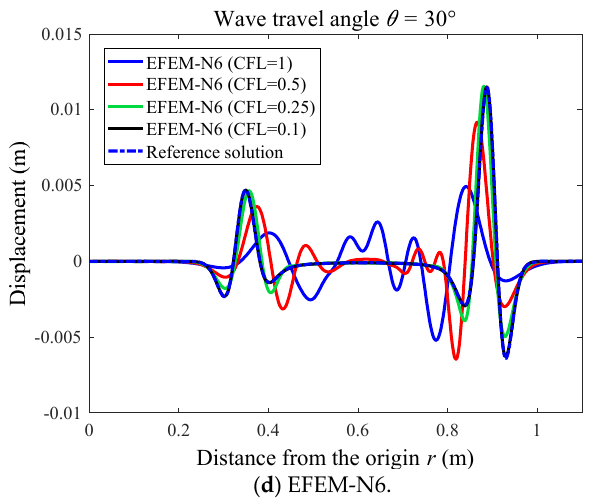
Figure 15. The displacement responses of the square membrane with holes from various methods by varying the employed nondimensional temporal discretization interval.